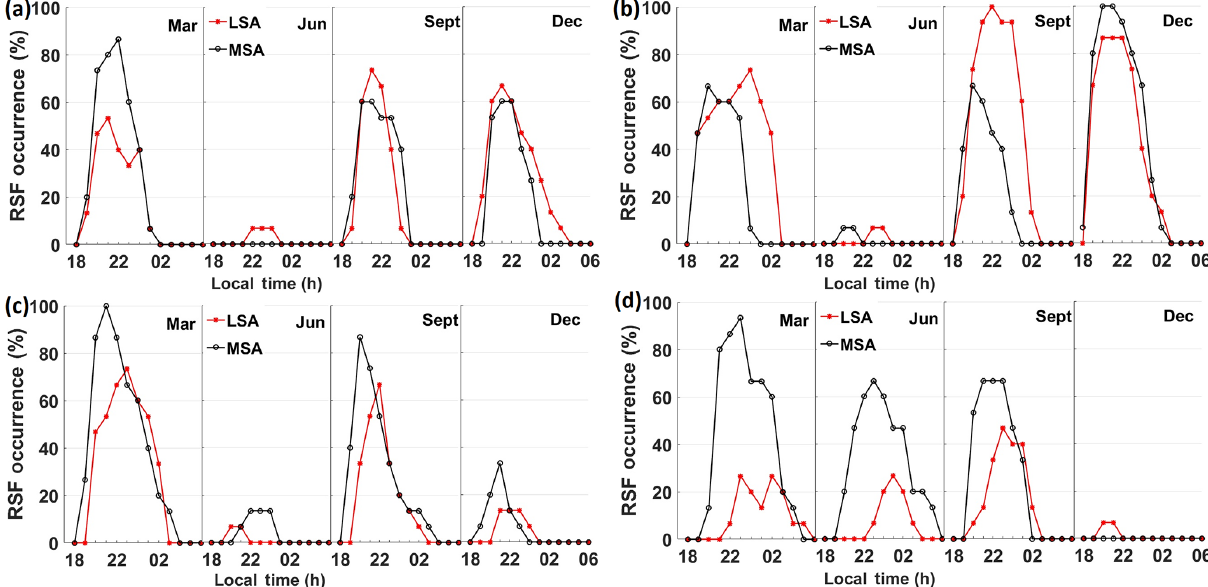
Figure 6. The percentage of ESF occurrences during the LSA and MSA periods for (a) Jicamarca, (b) Fortaleza, (c) Chumphon and (d) Kwa- jalein